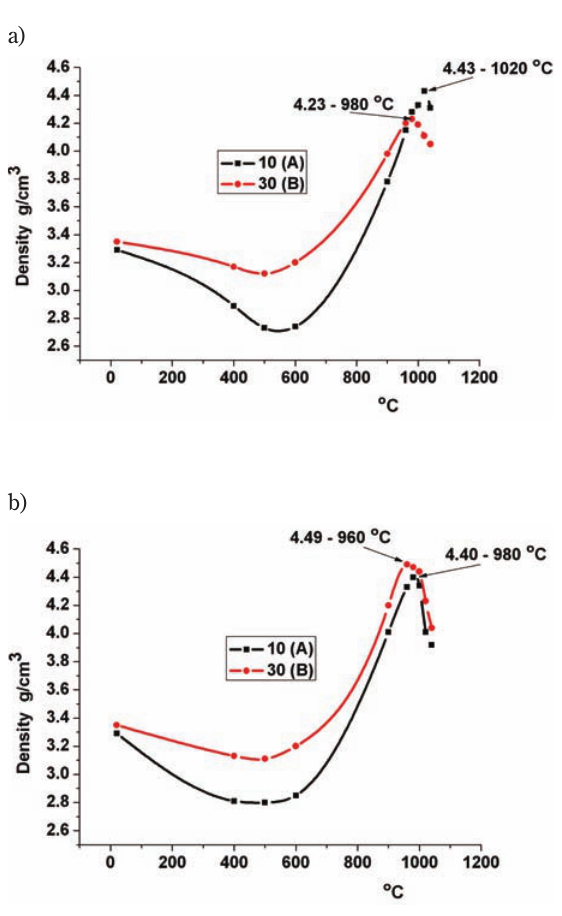
Fig. 6 Dependence of the change to the mean den- sity of samples on the temperature of ther- mal treatment: А -activation time 10 minutes, В -activation time 30 minutes. Copper oxide content: a) − 0.1 CuO; b) −